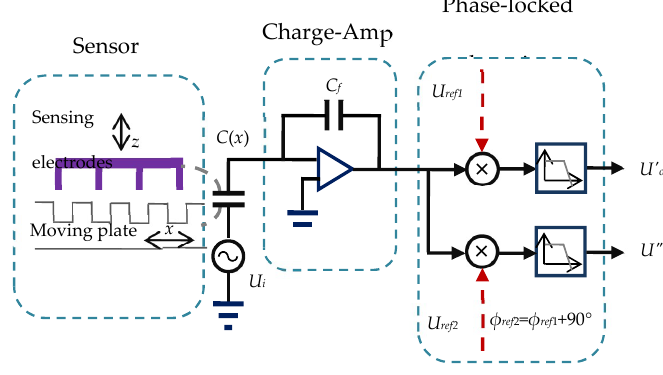
Figure 5. Diagram of capacitance measurement using phase-locked detection.